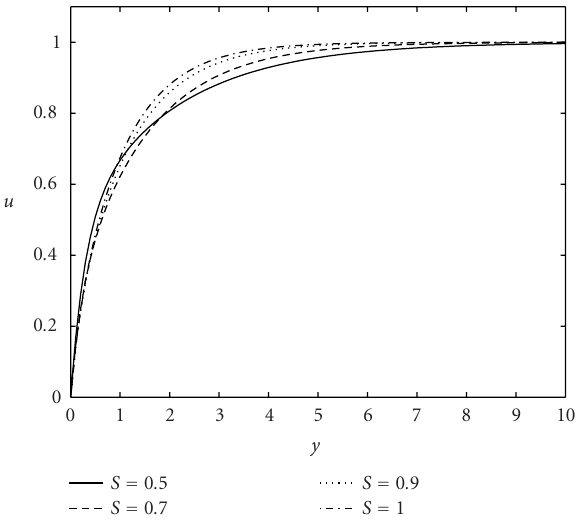
Figure 4.2. Main flow velocity u for Gr = 5 . 0, Pr = 7 . 0, ω = 10, z = 0 . 2, t = 0 . 2, (cid:2) = 0 .